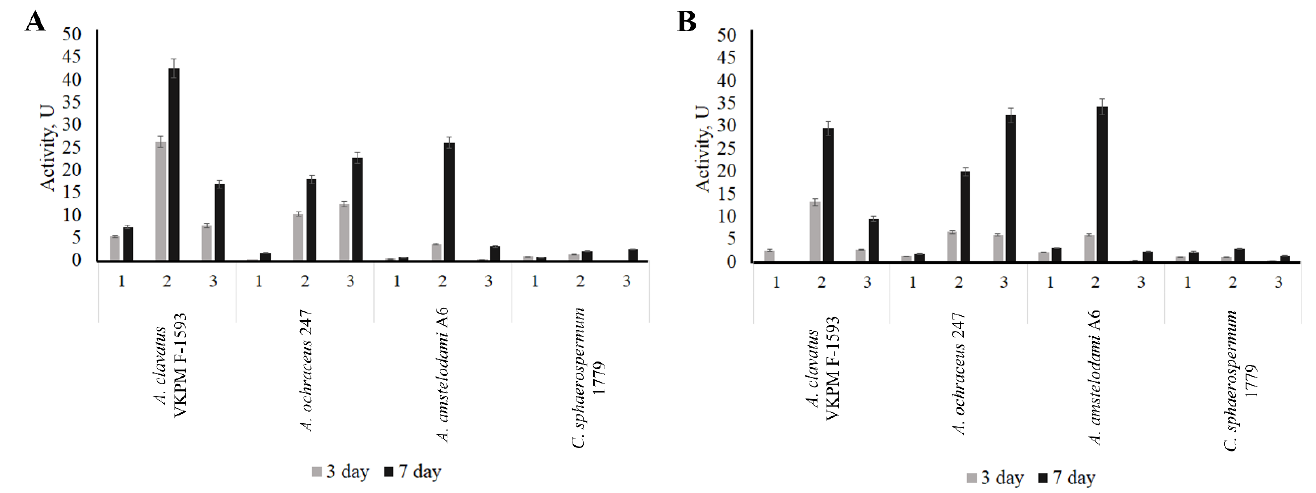
Figure 2. Keratinolytic ( A ) and caseinolytic ( B ) activity of selected fungi cultivated under submerged conditions on three different media: medium with wool keratin (1); medium with wool keratin and sodium nitrate (2); medium with sodium nitrate (3).